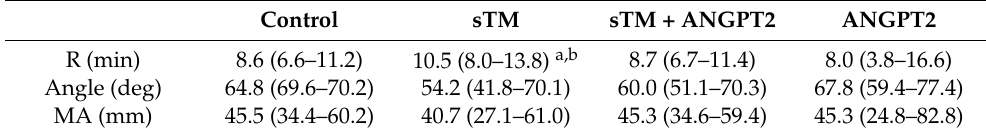
Table 1. TEG data from in vitro experiments.